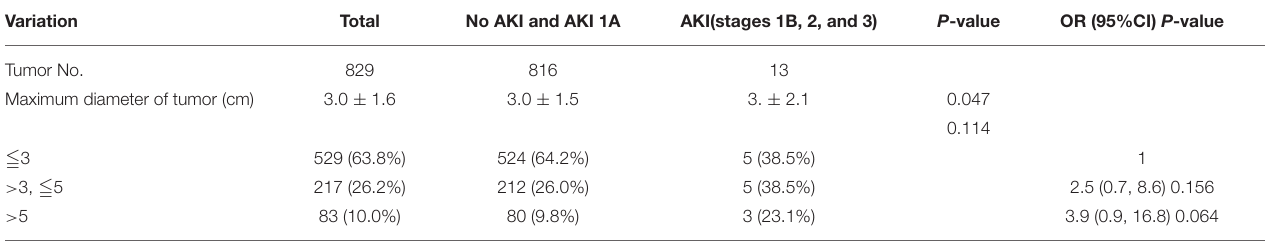
TABLE 2 | Baseline and univariate analysis of maximum diameter for patients with solitary tumor. Variation Total No AKI and AKI 1A AKI(stages 1B, 2, and 3) P -value OR (95%CI) P -value Tumor